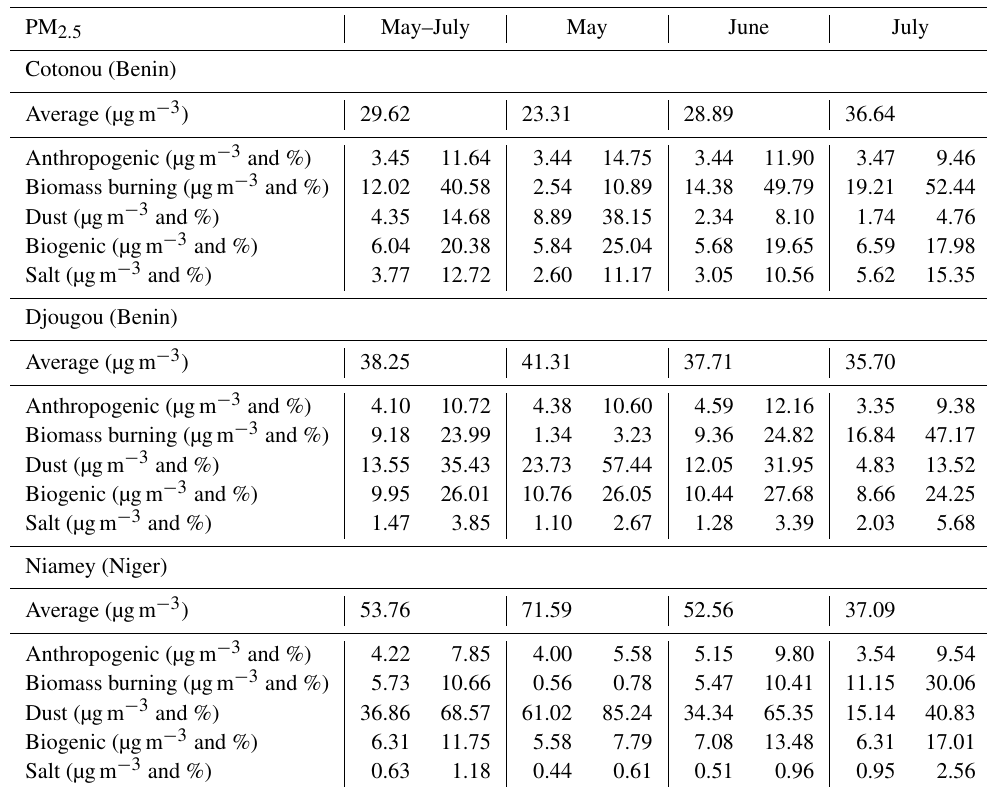
Table 3. PM 2 . 5 (µgm − 3 ) average and relative contributions (%) of type of pollution source (anthropogenic, biomass burning, dust, biogenic, sea salt) at Cotonou (Benin), Djougou (Benin) and Niamey (Niger). The time-averaged periods correspond to each month (May, June July) and to the whole period (from May to